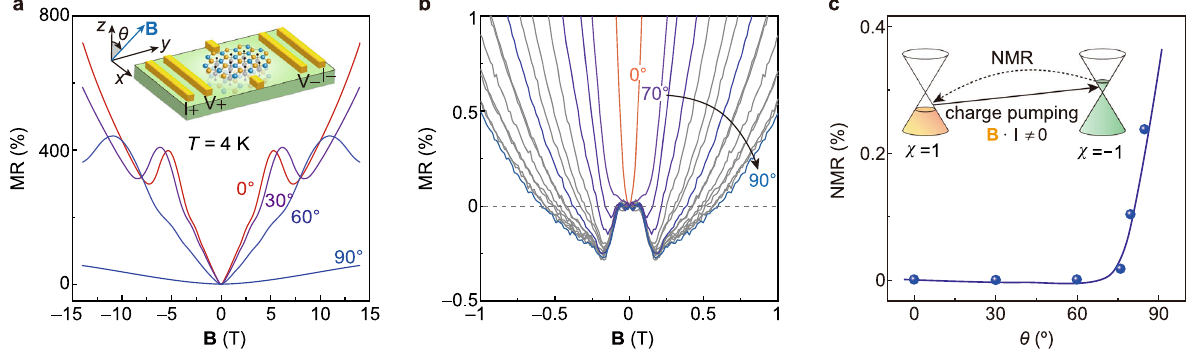
Fig. 4 Unusual angle-dependent chiral magnetic effect. a θ -dependent MR for θ = 0°, 30°, 60°, and 90° at T = 4 K, showing the maximal positive value of ~700% ( θ = 0°, B = ±14 T) with SdH oscillations. Illustration of the θ -dependent MR measurements is given in the inset. b Magni fi ed MR in the range of − 1 T ≤ B ≤ 1 T. NMR starts to appear at 70° and its magnitude reaches the minimum of ~0.25% at 90°. c Magnitudes of the NMR (blue dots and line) as a function of θ , showing a crossover at ~70°. The θ dependence of NMR is described by chiral magnetic effect (inset) in 3D TDS, which occurs under the collinear B and I. χ = ±1 indicates chiralities of both Weyl cones. The chiral charge pumping induces a subsequent relaxation current, which is free from backscattering because of chirality protection and, therefore, is leading to a reduction of